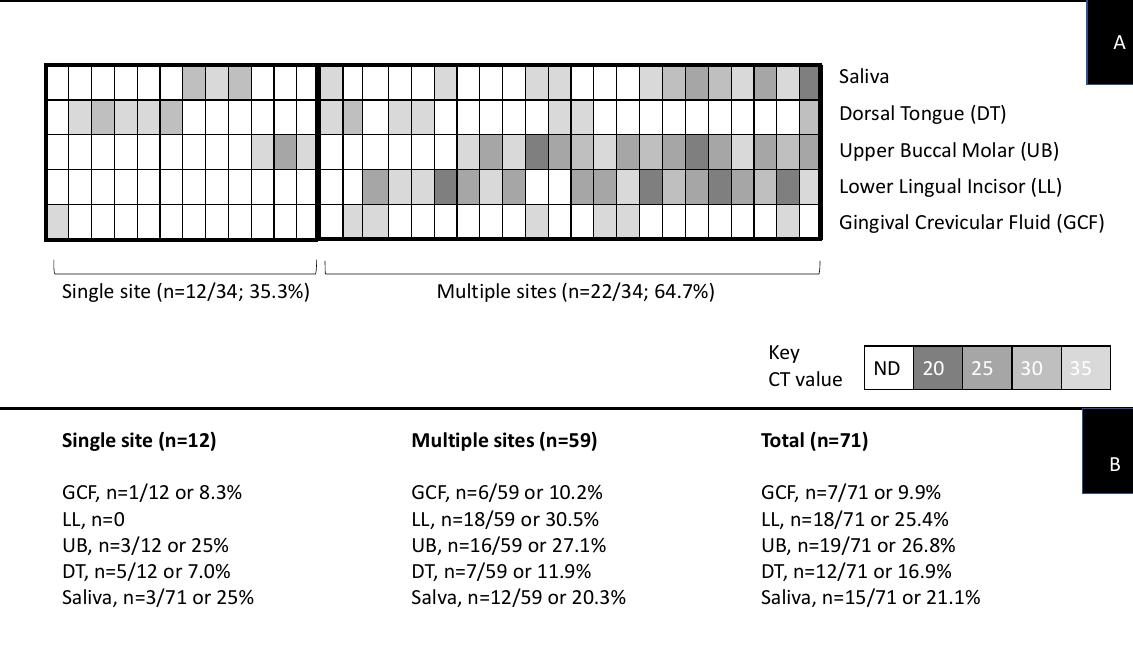
Figure 2. Heat map of study sample molecular screening for S. wiggsiae . ( A ) Heat map of the qPCR screening revealed a total of n = 34/60 or 56.7% of patient samples harboring SW. ( B ) A total of n = 71/170 specific oral sites harbored this organism, with the majority of the SW-positive participant samples harboring SW at more than one oral site, n = 22/34 or 64.7%. Note: Key indicates relative DNA abundance through CT values: 20 = greater abundance; 35 = less abundant.